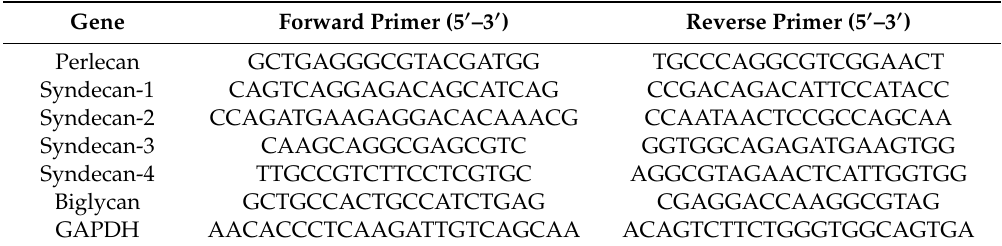
Table 1. Bovine gene-specific primers for